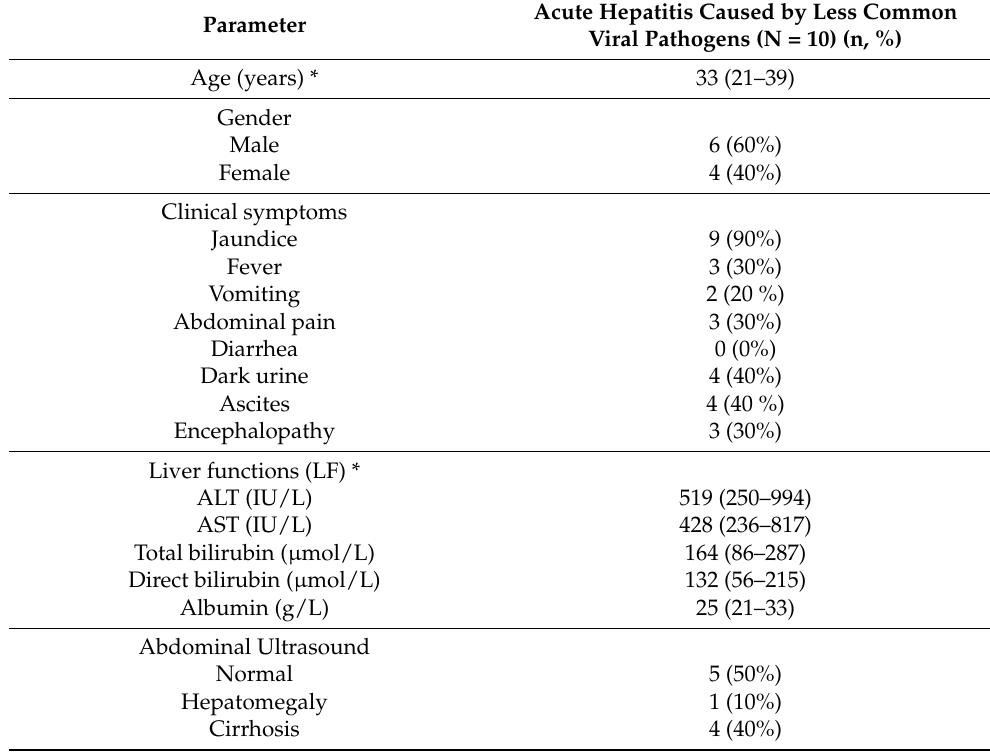
Table 4. Demographic, clinical, and laboratory parameters of acute hepatitis caused by less common viral